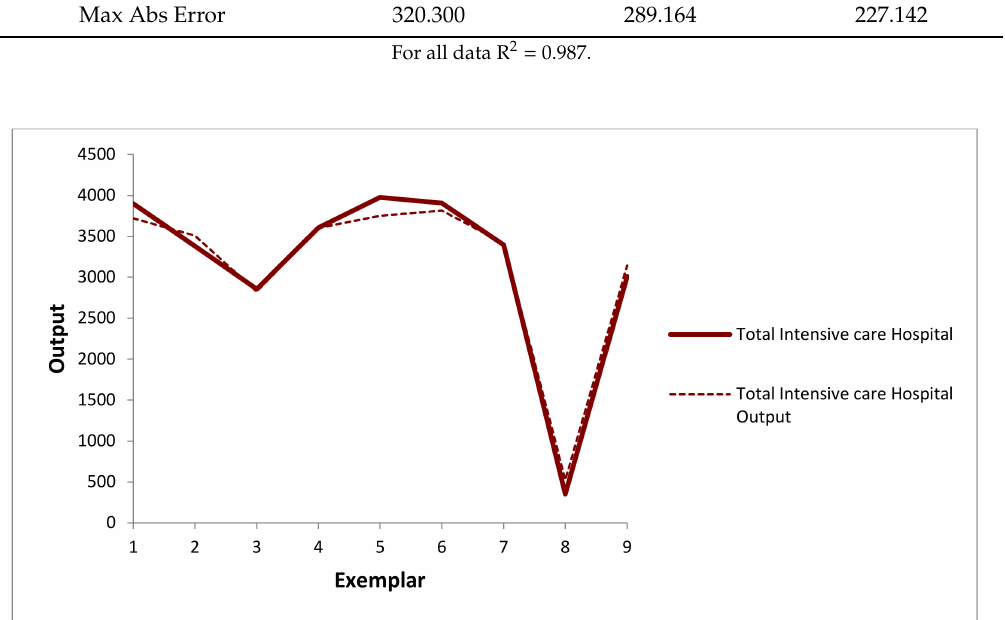
Figure 6. Predicted values by the ANN algorithm vs. testing